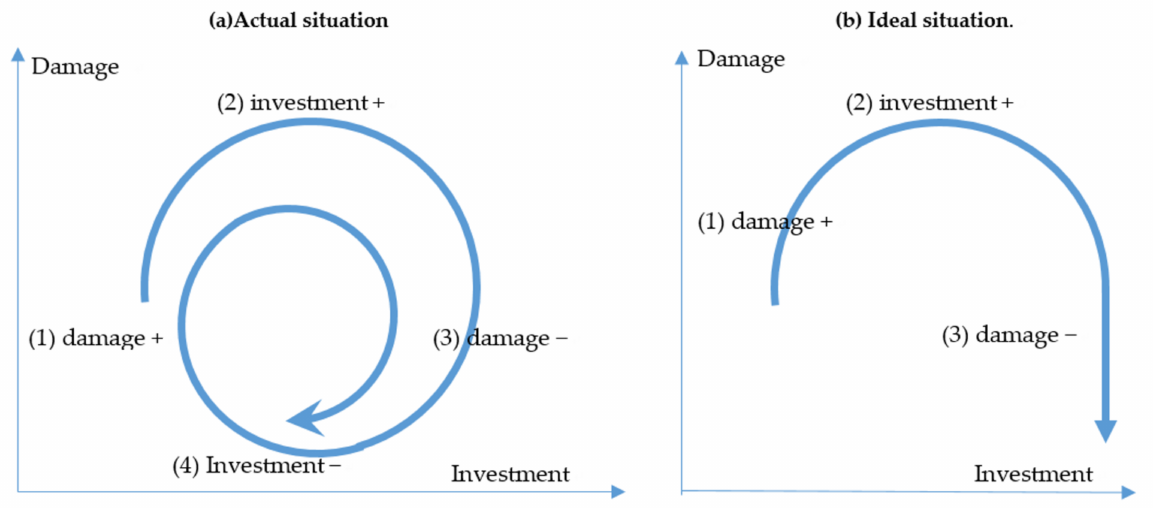
Figure 1. Concept of investment cycle. Source: Authors’